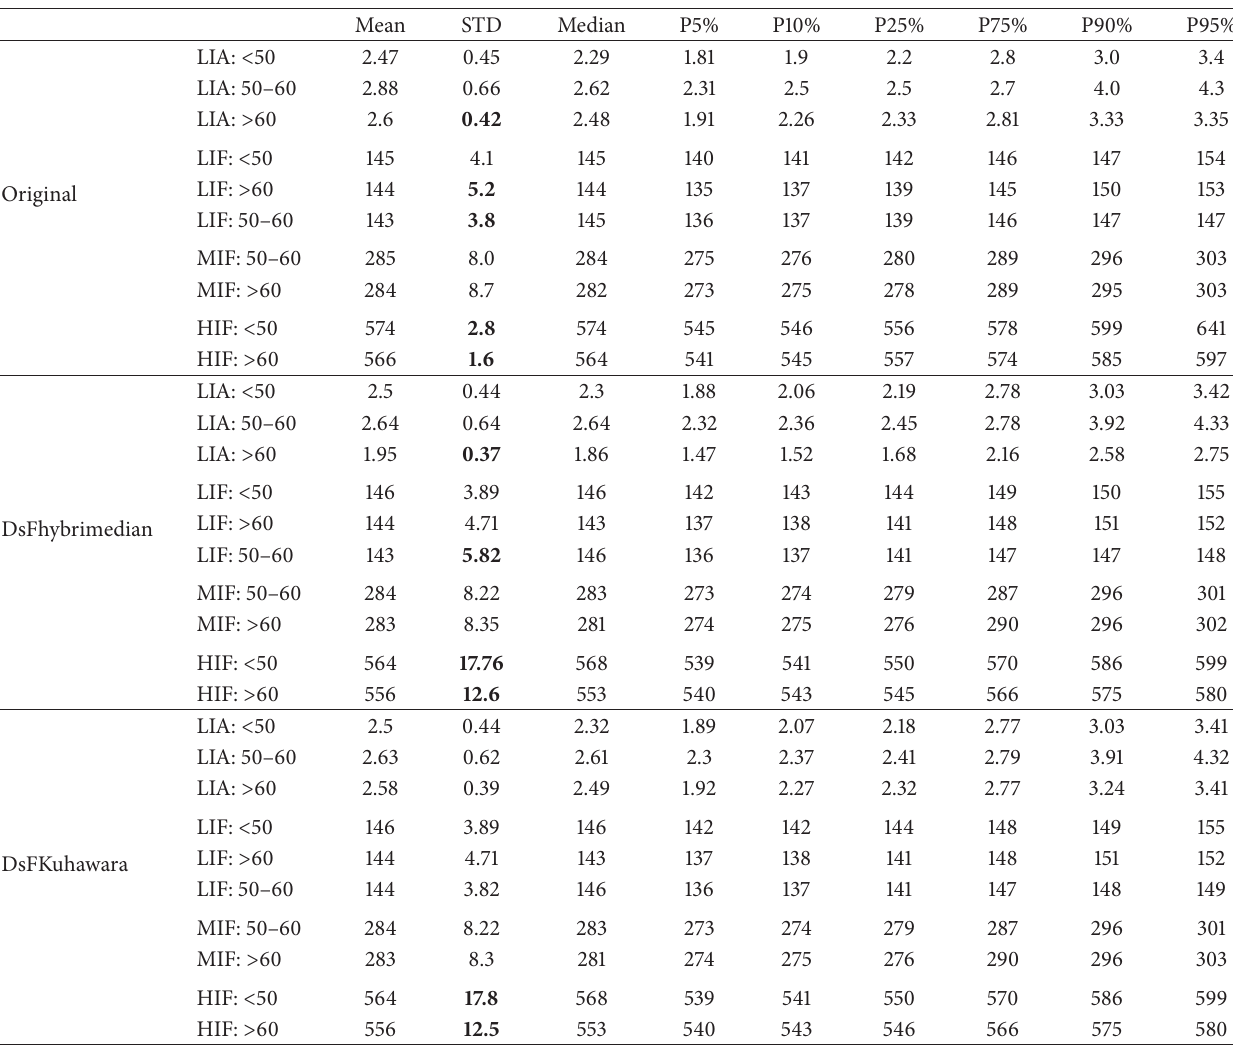
Table 4: Comparison of the mean, standard deviation (STD), median, and different quartile ranges between the high, medium and low AM- FM features extracted from the IMC for the three different age groups, below 50 ( < 50), between 50 and 60 (50–60) and above 60 ( > 60) years old for the original, the DsFhybrimedian and the DsFkuhawara filters. Here, the IA and IF values have been pre-multiplied by 100 for better visualization. Recall that the original images were normalized to a maximum brightness value of 1. Thus, the IA values represent a percentage of the maximum input image intensity. The instantaneous frequency magnitude, IF, is measured in cycles/mm (100x, Magnified by